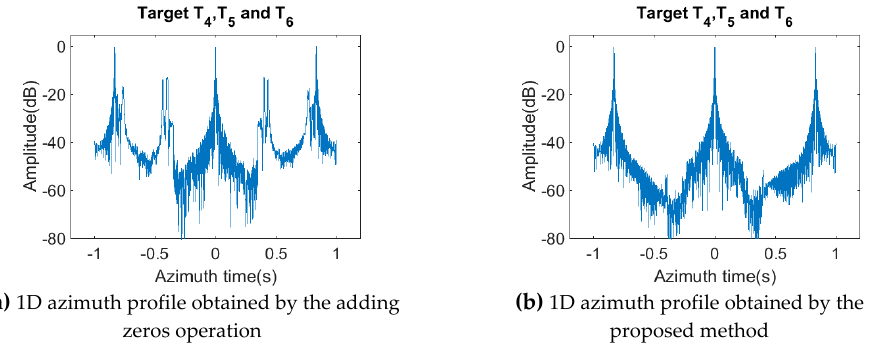
Figure 15. 1D Azimuth profiles of T 4 , T 5 , and T 6 : ( a ) 1D azimuth profile obtained by the adding zeros operation; and ( b ) 1D azimuth profile obtained by the proposed method.